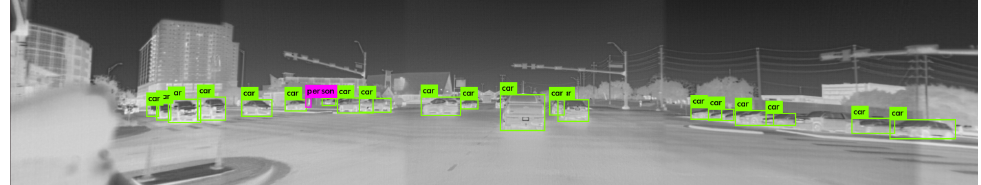
Figure 8. An example of the output of the object detector running on the thermal images.